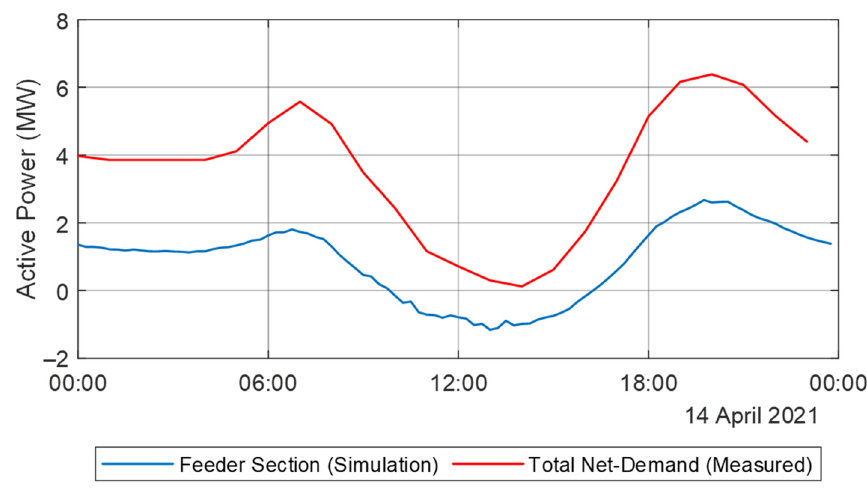
Figure 7. The measured total net-demand profile vs. simulated net-demand for the considered feeder section at Xewkija DC.